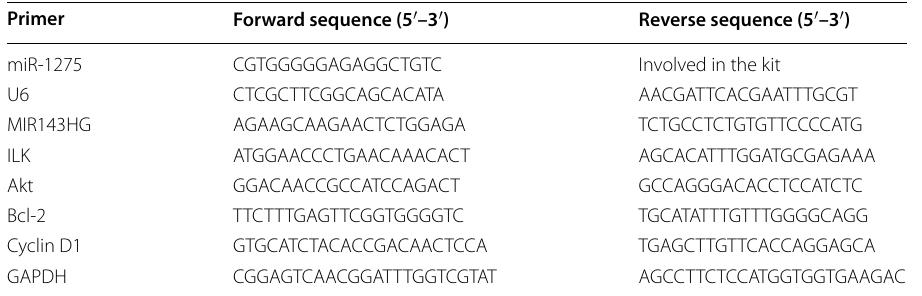
Table 1 Primers used for RT-qPCR Primer Forward sequence (5 ′ –3 ′